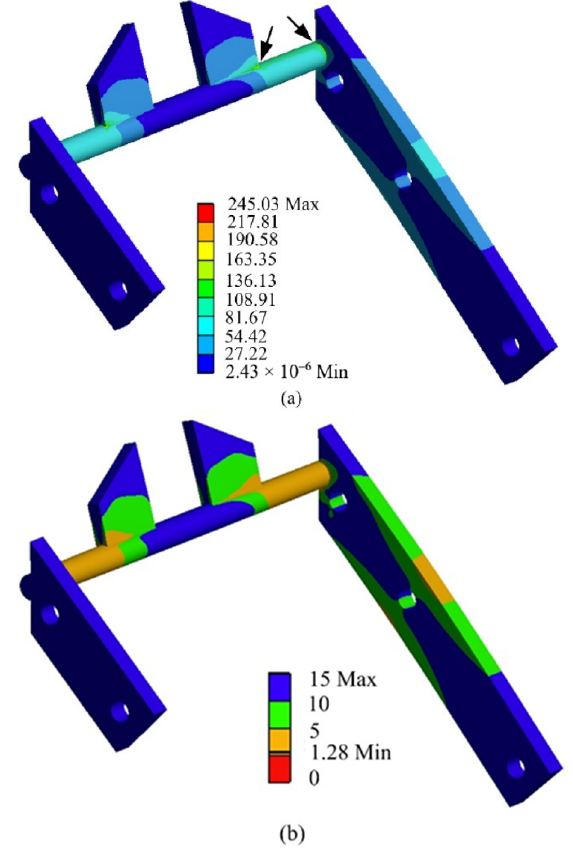
Figure 10. Diameter reduction of the horizontal rod (10 mm) at 100,000 load cycles: ( a ) calculated alternating stress (MPa) with the most stressed places indicated by black arrows and ( b ) the safety factor.